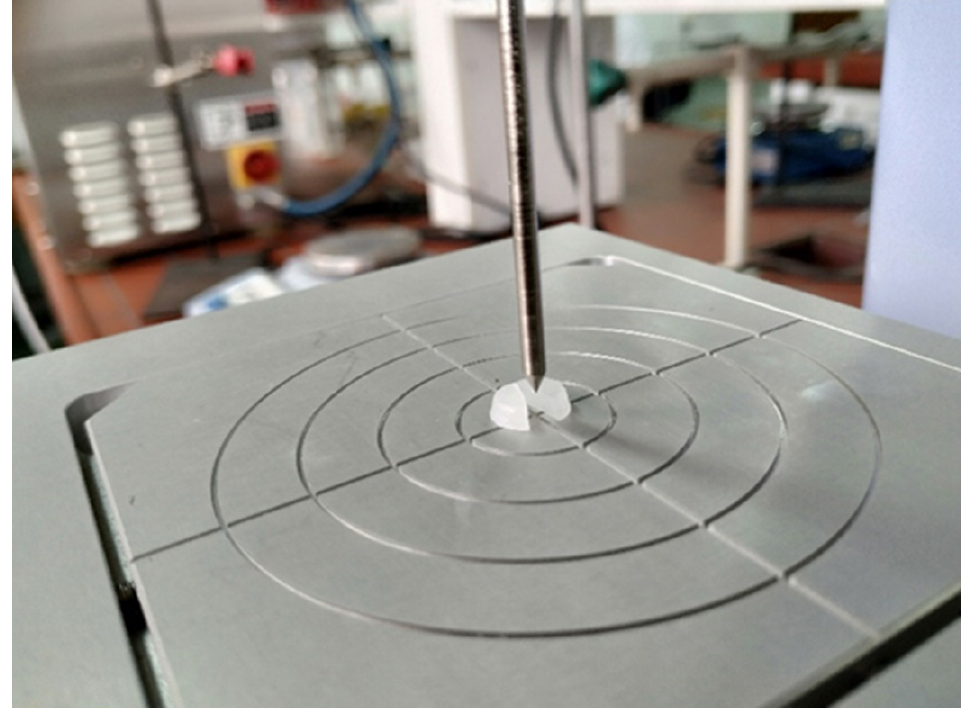
Figure 3. Determination of mechanical properties of the tablets on EZ-LX Compact Table-Top Testing Machine.